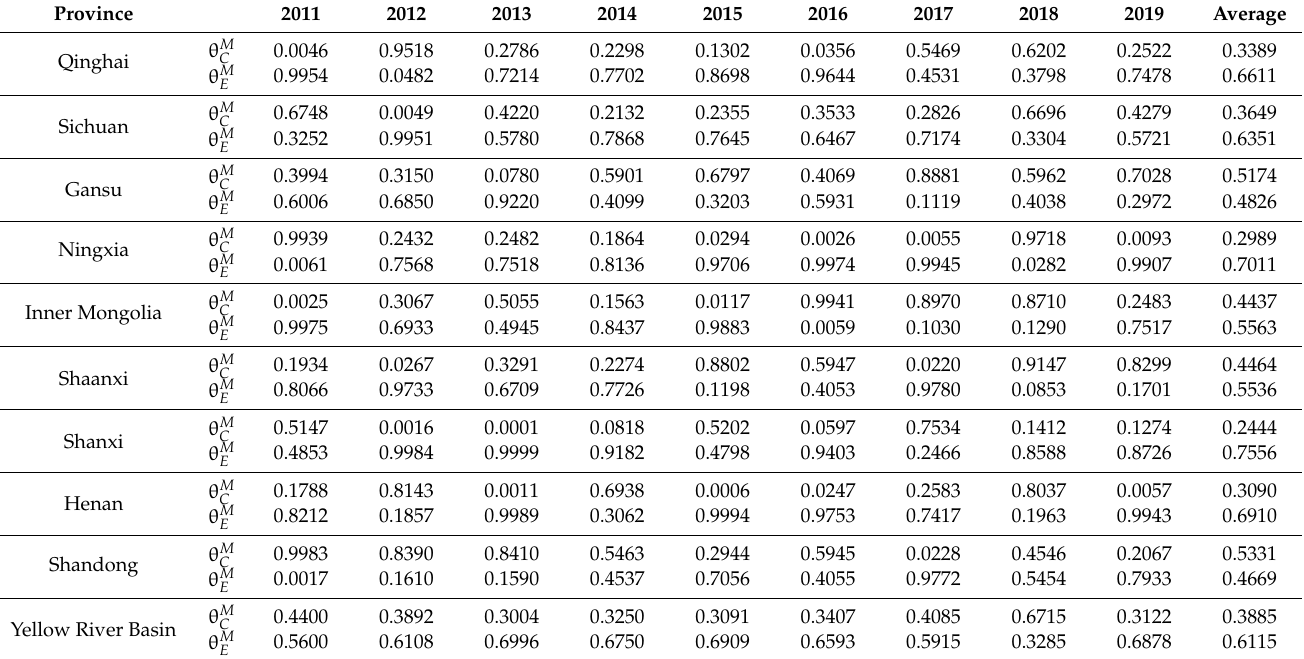
Table 8. Symbiosis coefficient of tourism’s carbon emission efficiency (TCEE) and the tourism economy’s high-quality development